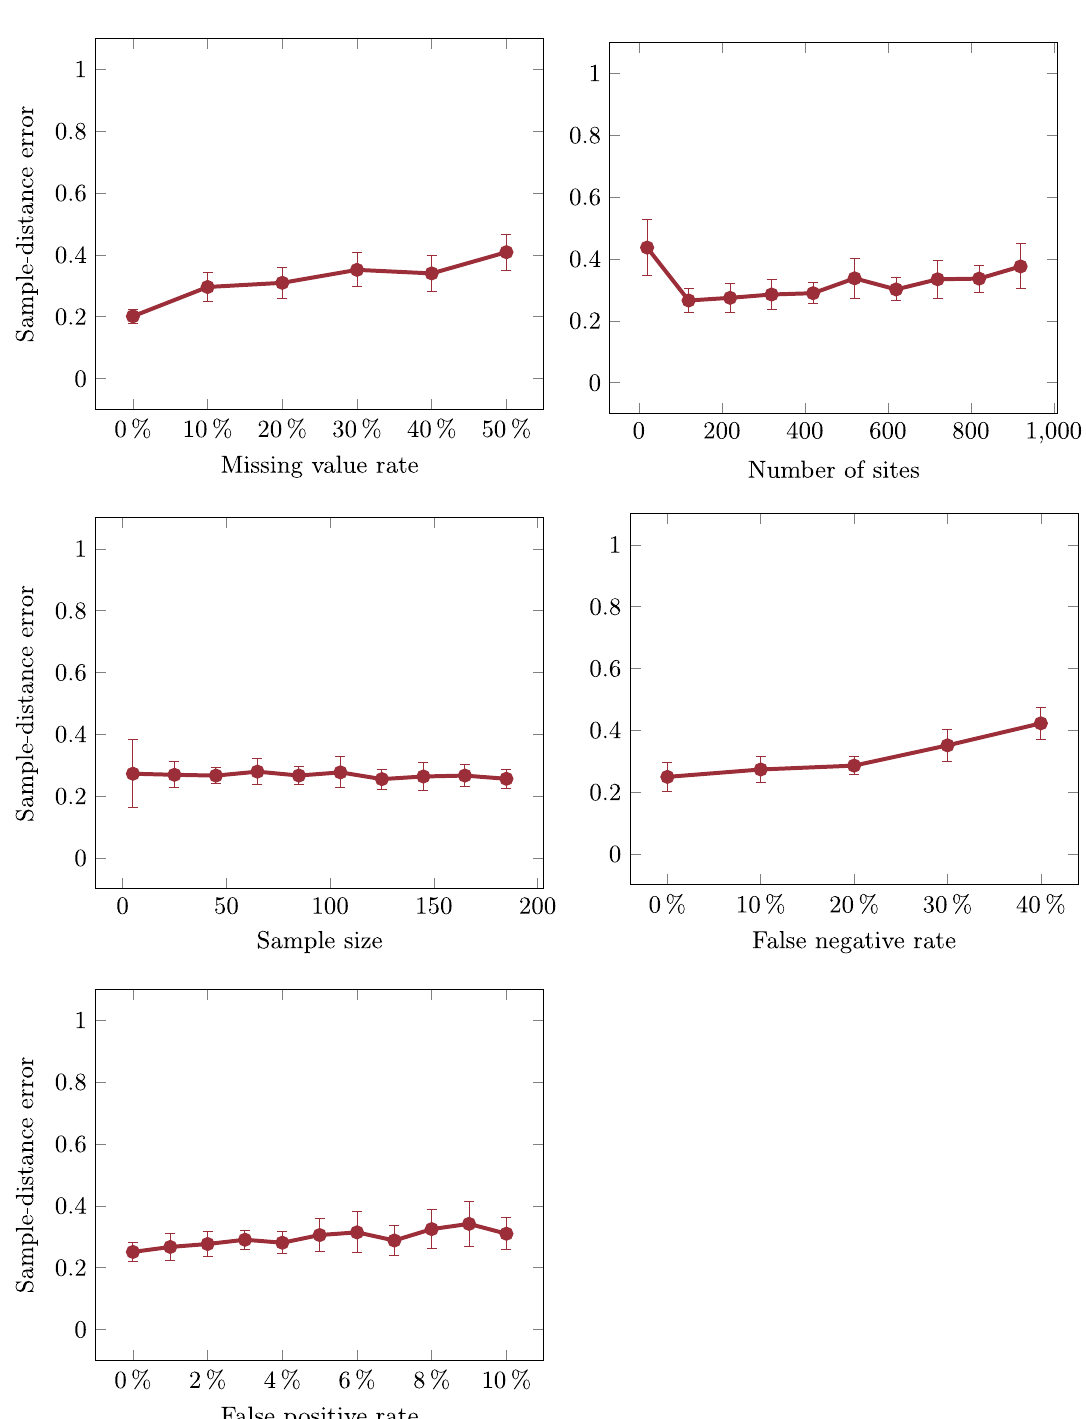
PLOS Computational Biology | https://doi.org/10.1371/journal.pcbi.1009100 August 11,